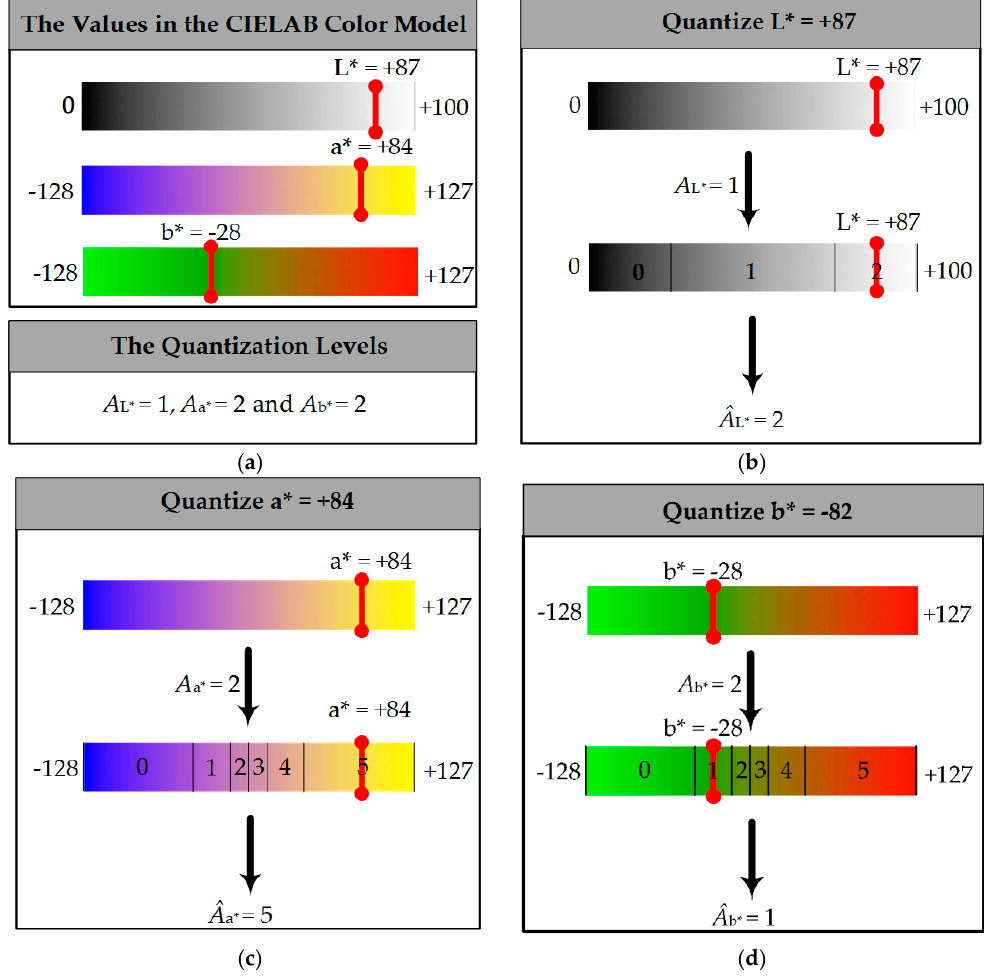
Figure 3. An example of the proposed quantization scheme: ( a ) The values and its quantization levels in the CIELAB color model; ( b ) The quantization in the L* component; ( c ) The quantization in the a* component; and ( d ) The quantization in the b* component.